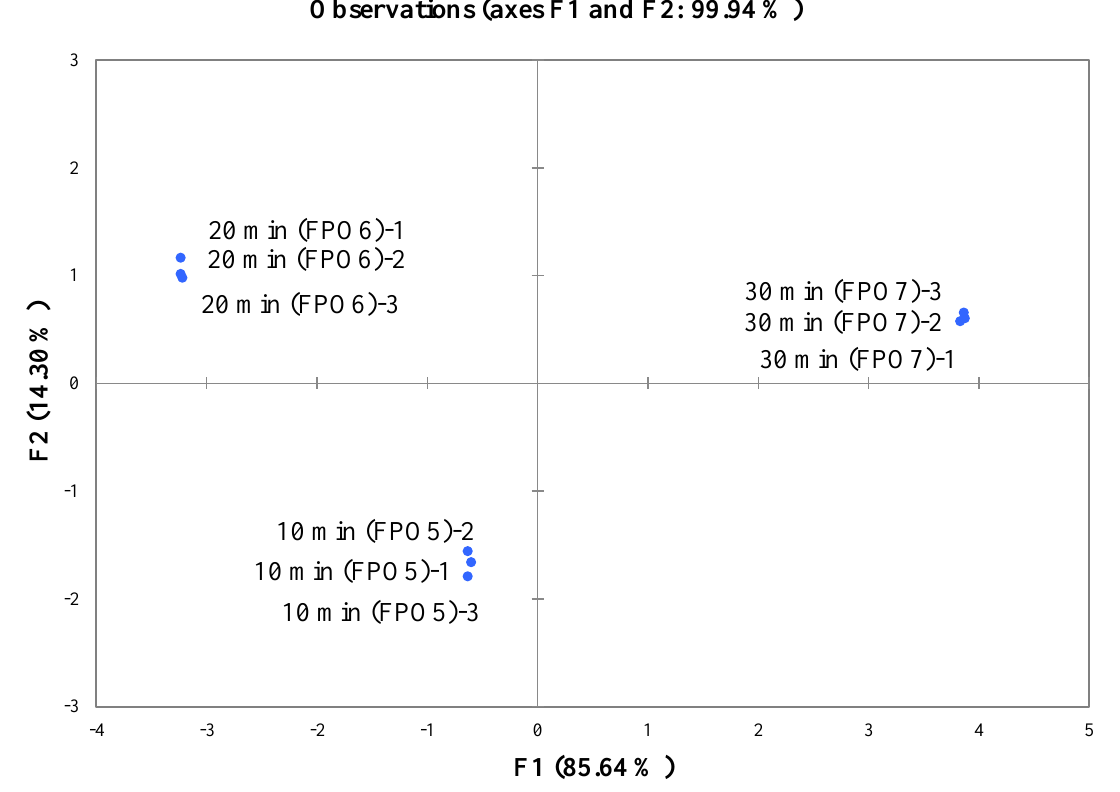
Figure 4. PCA chart for aroma profiles of FPOs with different frying times. As can be seen in Figure 5, with the increase in frying temperature, the content of various volatile compounds changed more significantly, especially terpenoids, alcohols, and esters. The content of terpenoids showed a gradual decrease with the increase in frying time. Most of the terpenoids, such as δ -3-carene, copaene, β -myrcene, limonene, and so on, originated from the pepper fruits [23]. When the frying time was short, these compounds were released from the pepper fruits and dissolved in the oil. With longer frying times, these times could either undergo chemical reactions, such as oxidation or degradation, and thus transform into other substances, or they could volatilize into the air, thus causing losses. Some of the alcohols, such as 1,8-cineole and linalool, in the FPOs originated from the pepper fruits [24,25], and other alcohols were derived from the oxidative decomposition of unsaturated fatty acids and the positional isomerization of double bonds on the carbon chain during deep frying [20,26]. For instance, 1-octen-3-ol (which has a mushroom-like odor) was formed from the decomposition of linoleic acid through hydrogen peroxide [27], which had a relatively low human odor threshold of 0.0015 mg/kg, and this had some influence on the overall aroma of the FPO. During the frying process, certain compounds Table 2. Volatile compounds in pepper oils with different frying times as determined by GC – MS. in the pepper fruits could have promoted the oxidation of unsaturated fatty acids in the oil; therefore, the content of the alcohols showed a gradual increase. The esters were derived from the esterification reaction between the alcohols and acids, and the content of the esters increased gradually with the reaction for a certain period of time. Excessive frying time might lead to the decomposition of esters into other compounds, which could result in a lower content. Fat oxidation and the secondary decomposition of its oxidation products could have produced acid, but their contribution to the aroma of FPO was insignificant [28]. Aldehydes, including saturated and unsaturated aldehydes, which were the major volatiles produced by lipid oxidation during frying, showed a tendency to increase in content with time as the reaction